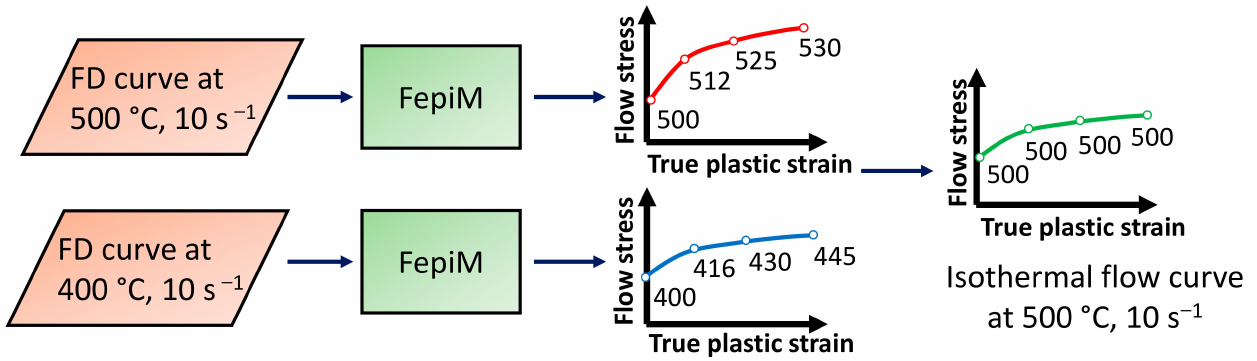
Figure 4. Block diagram for the flow curve determination at the highest temperature and strain